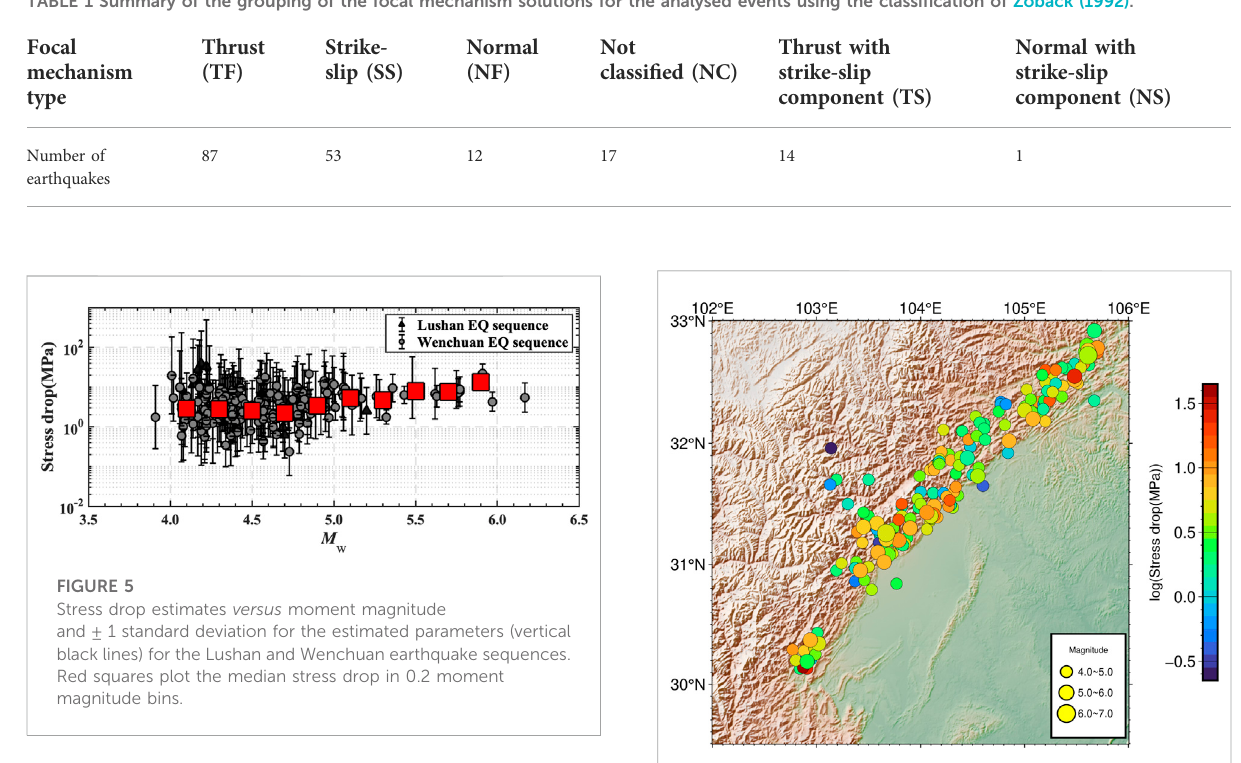
FIGURE 6 Spatial distribution of the stress drop in the LMS fault